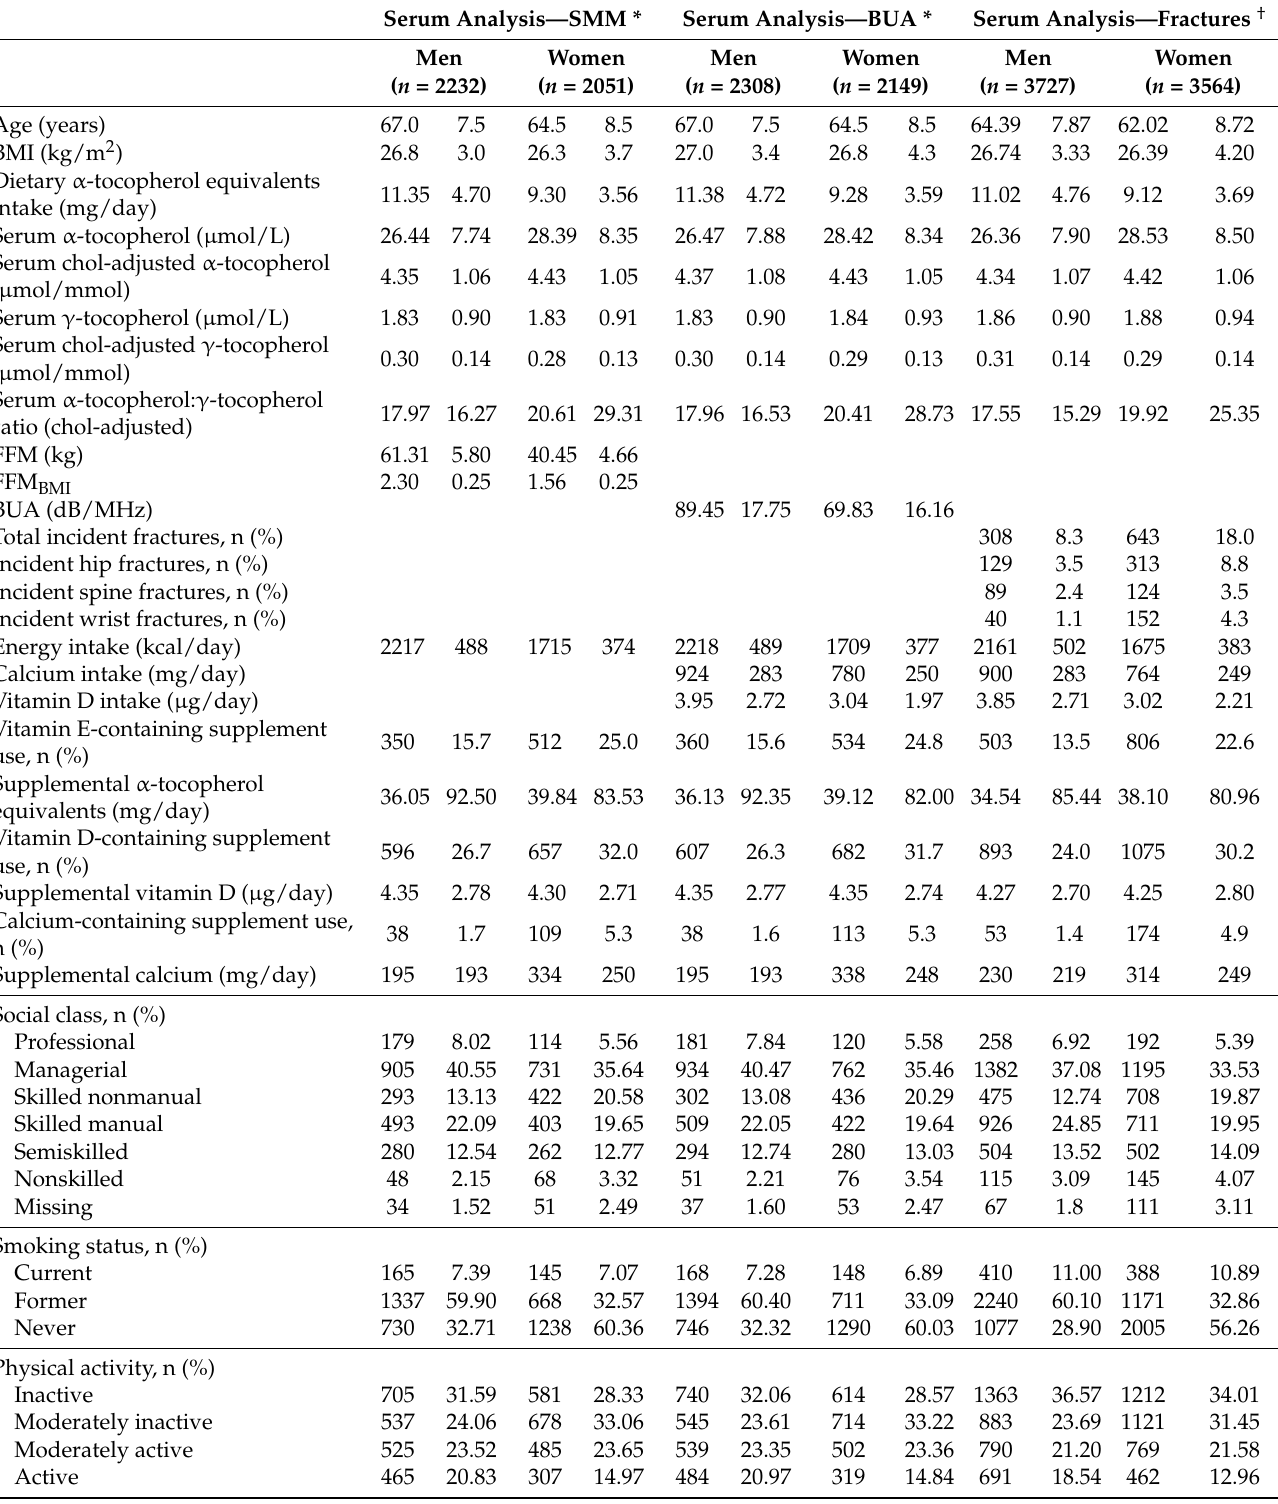
Table 2. Selected characteristics of the EPIC-Norfolk cohort population, stratified by sex and plasma analysis group. Serum Analysis—SMM * Serum Analysis—BUA * Serum Analysis—Fractures